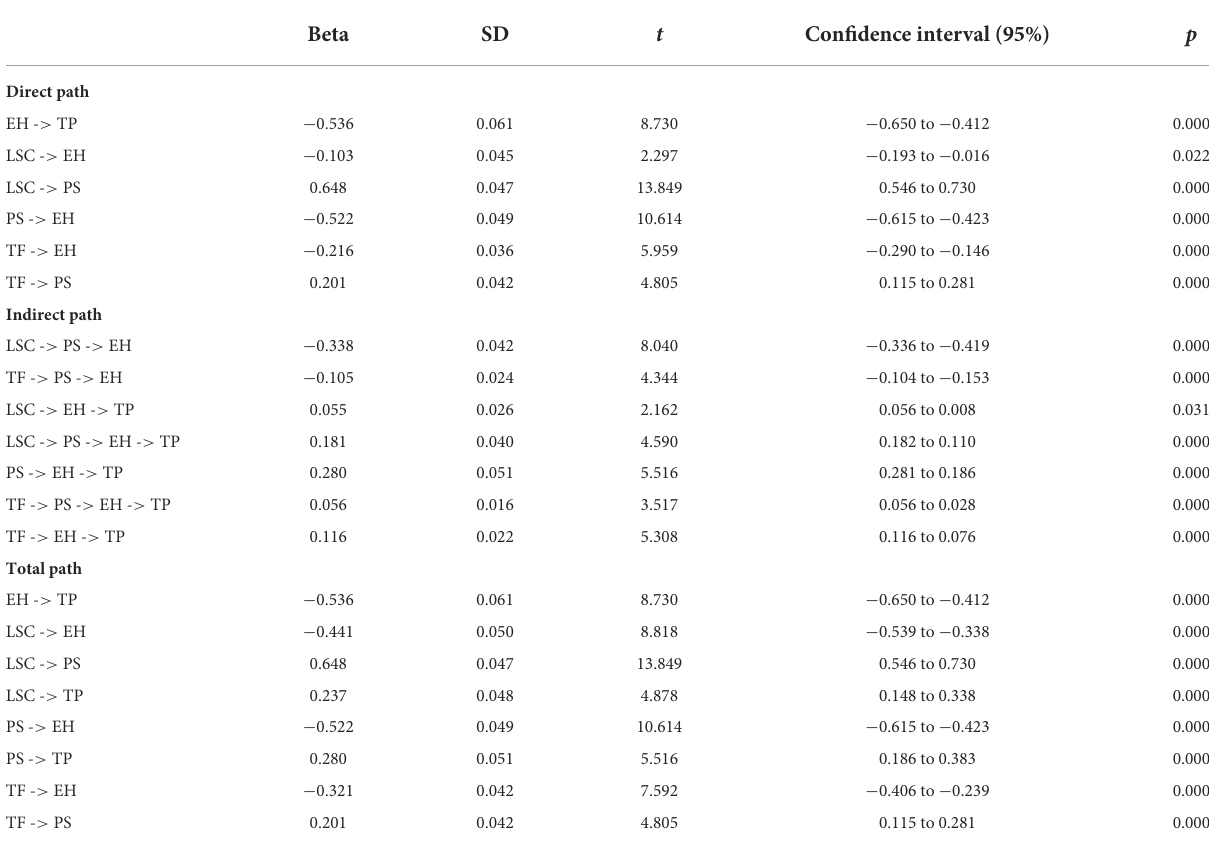
TABLE 4 Direct, indirect and total path estimates.